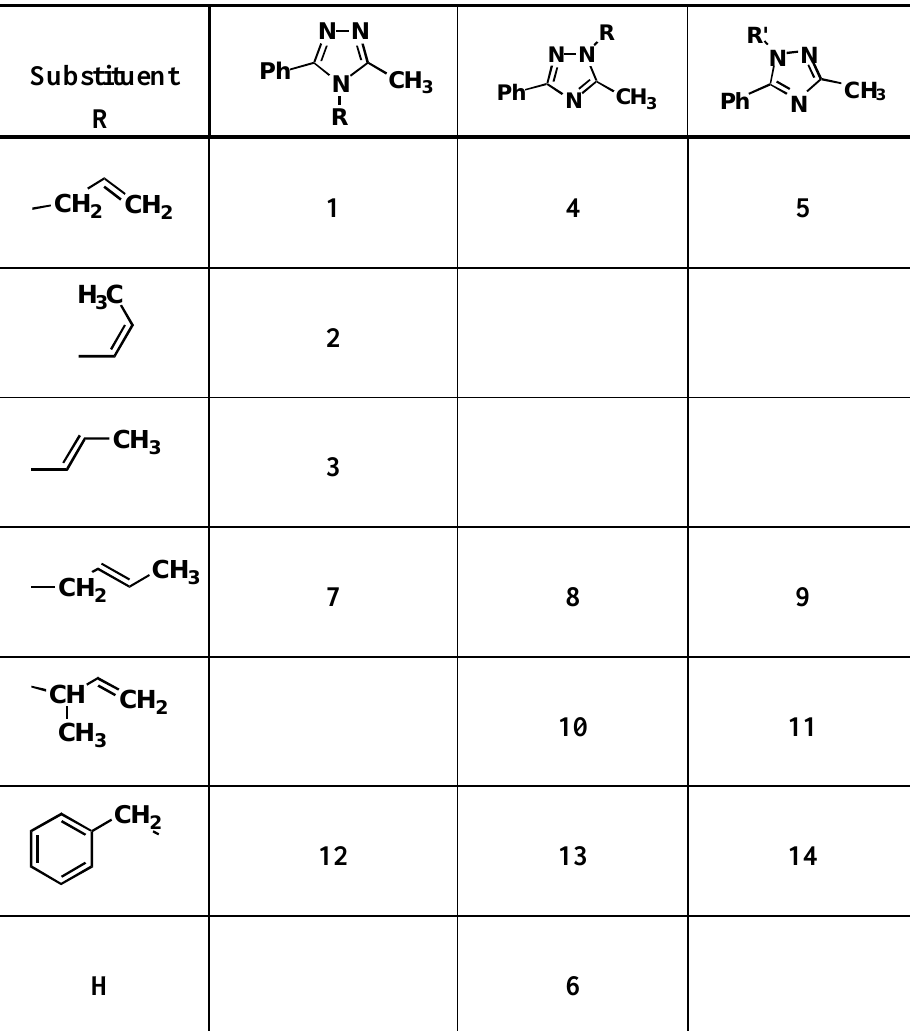
Table 2. The structures of the 3-Phenyl-5-methyl-1H-1,2,4-triazoles thermolyzed at 320 o C and the products